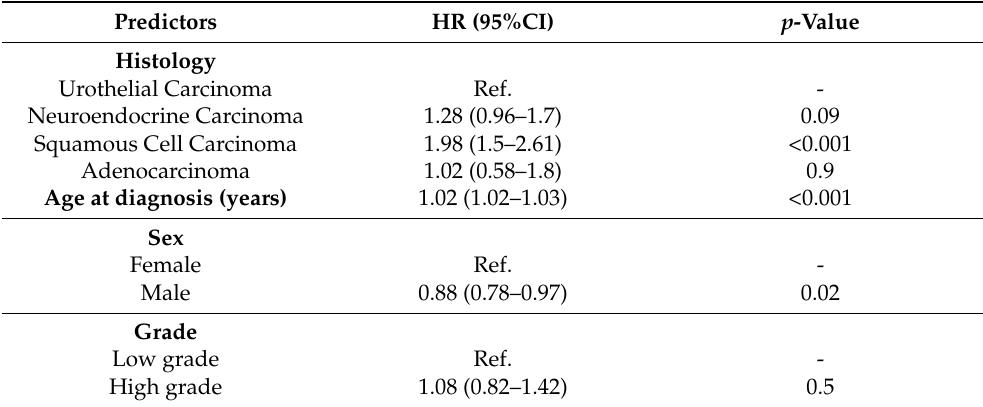
Table 2. Multivariable Cox-regression models testing predictors of cancer-specific mortality. Predictors HR (95%CI) p